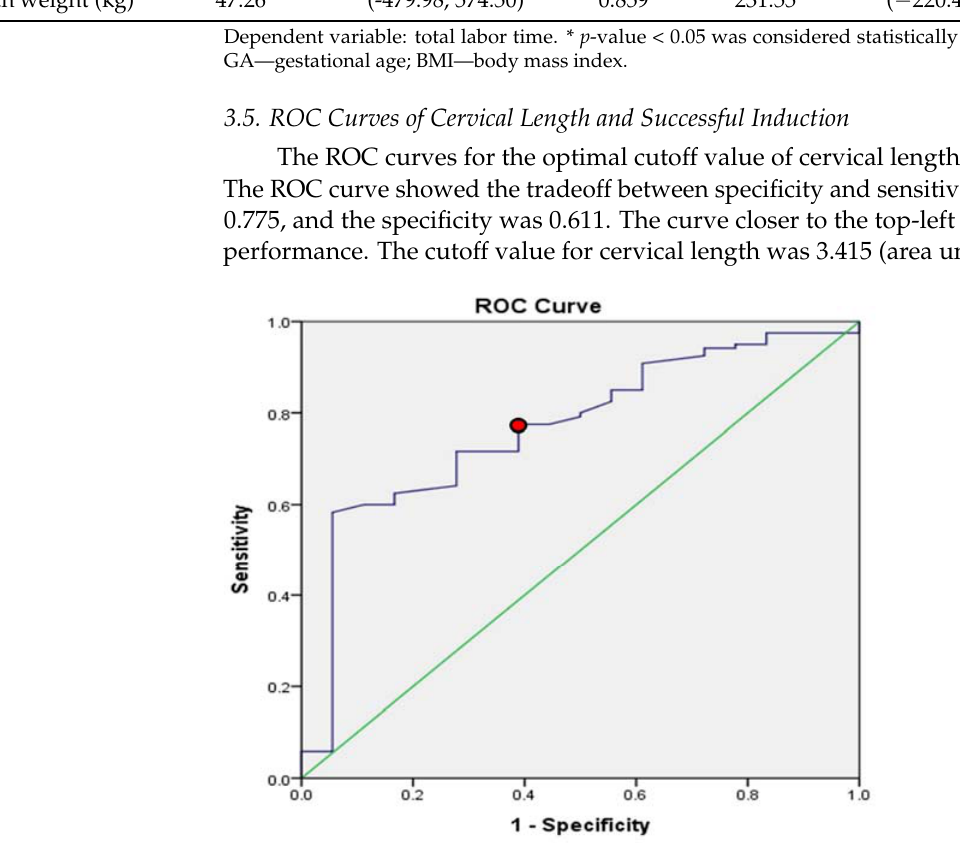
Figure 2. ROC curve for cervical length and successful induction. The ROC curve showed a cervical length set at 3.415 cm (area under the curve: 0.768); the sensitivity was 0.775, and the specificity was 0.611.